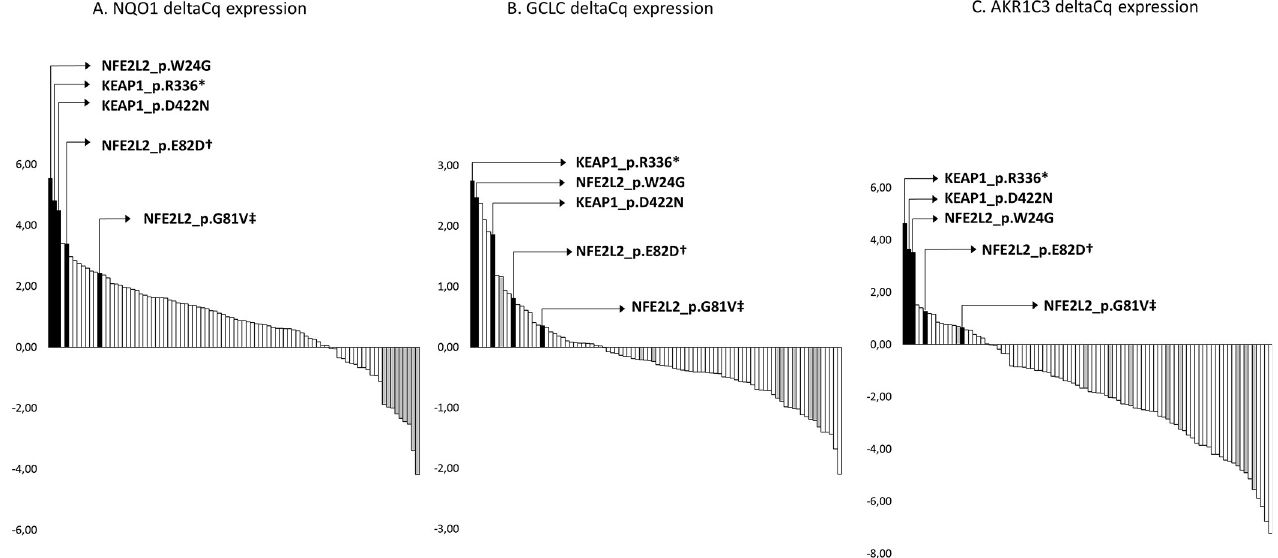
Fig 3. Distribution of NRF2 target genes expression and NFE2L2/KEAP1 mutations in endometrial tumors. NQO1, GCLC and AKRC3 expressions measured by quantitative RT-PCR are shown as waterfall plots. y- axis display delta Cq expression. Black bars: samples affected by NRF2 pathway activating mutations. Grey bars: samples considered as outliers regarding NQO1 low expression, based on the observation of a gap into the NQO1 expression distribution which mirrors the gap observed for the samples with high NQO1 expression. Grey bars in GCLC and AKR1C3 distribution depict corresponding samples. † NFE2L2 p.E82D with allele ratio = 14%, and ‡ NFE2L2 p.G81V with allele ratio = 16%, suggesting of a subclonal NRF2 activation. See Table 2 for details on NRF2 pathway mutations and annotations.